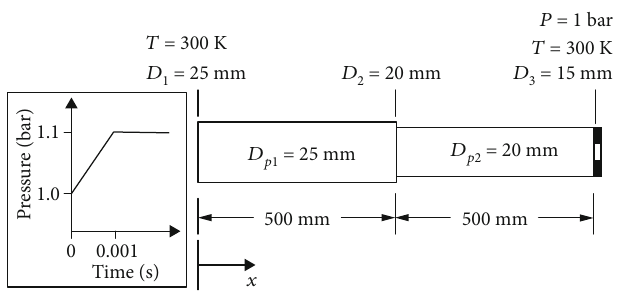
Figure 11: Simulated pipe parameters and boundary conditions.